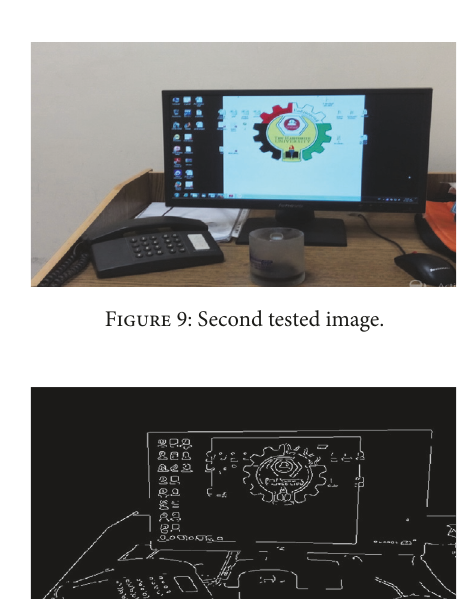
Figure 8: Fitness function value.